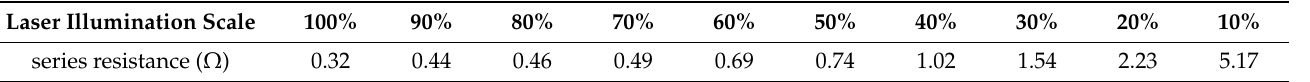
Table 1. Series resistance of laser photovoltaics under different laser illumination scales. Laser Illumination